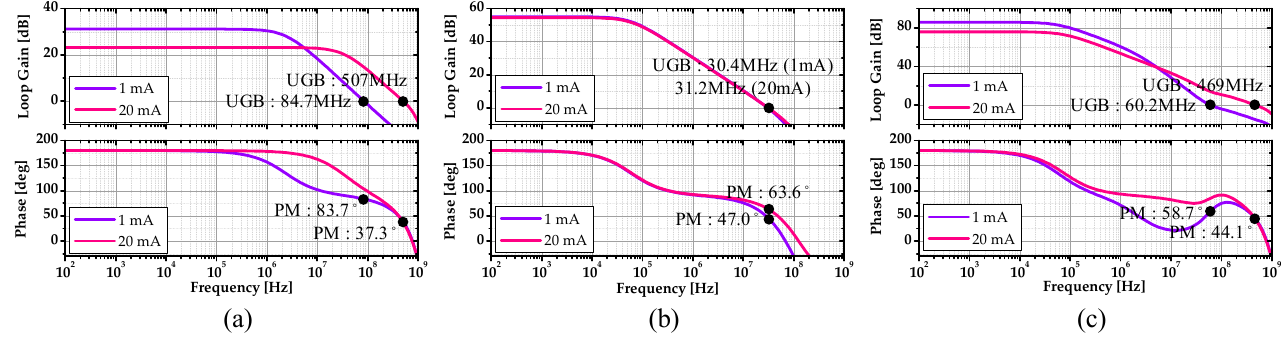
Figure 5. Phase margin simulation results of ( a ) Loop 1, ( b ) Loop 2, and ( c ) the overall loop.